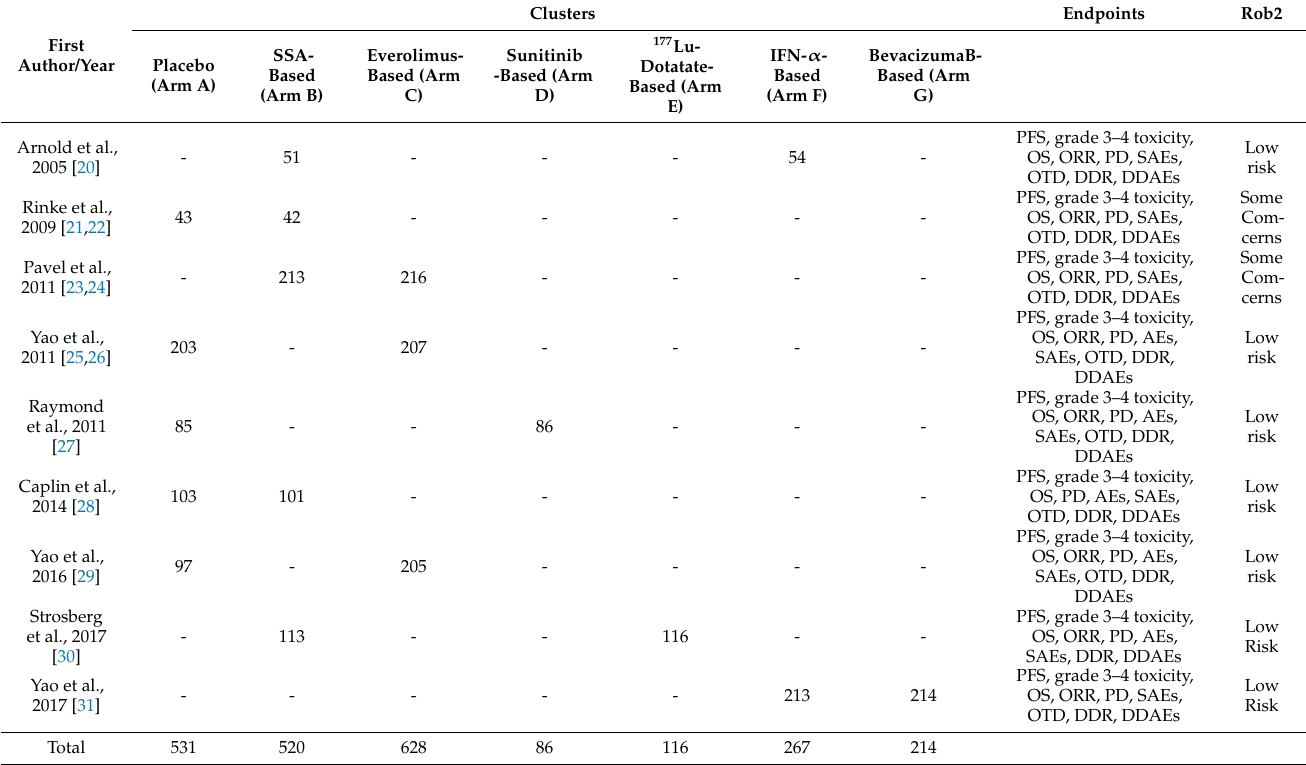
Table 2. Characteristics of the nine studies